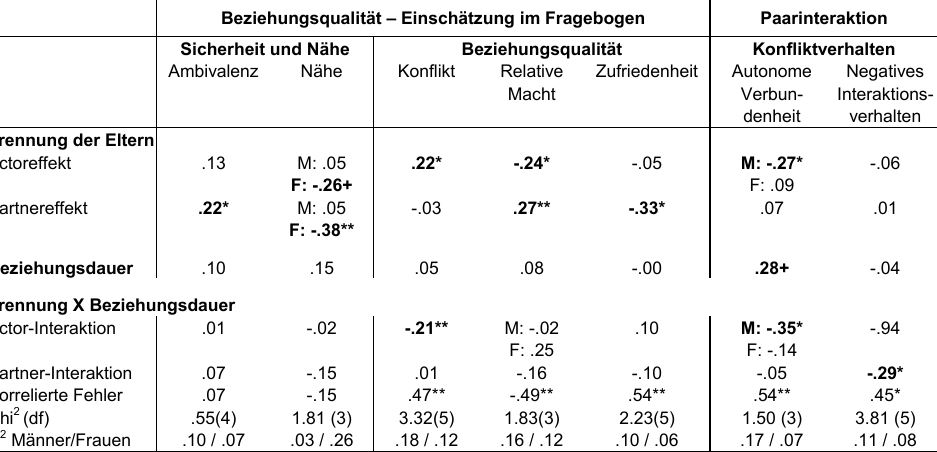
Tabelle 4 : Dyadische Analysen zum Einfluss einer elterlichen Trennung/Scheidung auf Merkmale der